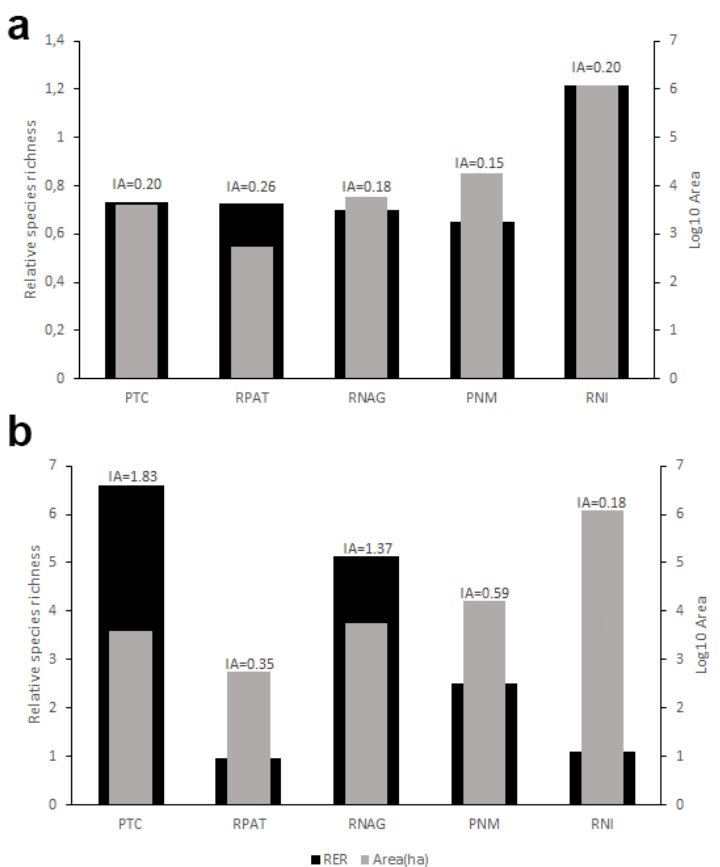
Figure 4. Comparative analysis of the importance of each area (IA) for amphibians (a) and reptiles (b) between the isolated rocky outcrops of Paraje Tres Cerros (PTC) and other areas from Corrientes province. Reserva Natural Provincial Isla Apipe Grande (RNAG), Reserva Paleontológica del Arroyo Toropí (RPAT), Reserva Natural del Iberá (RNI) and Parque Nacional Mburucuyá